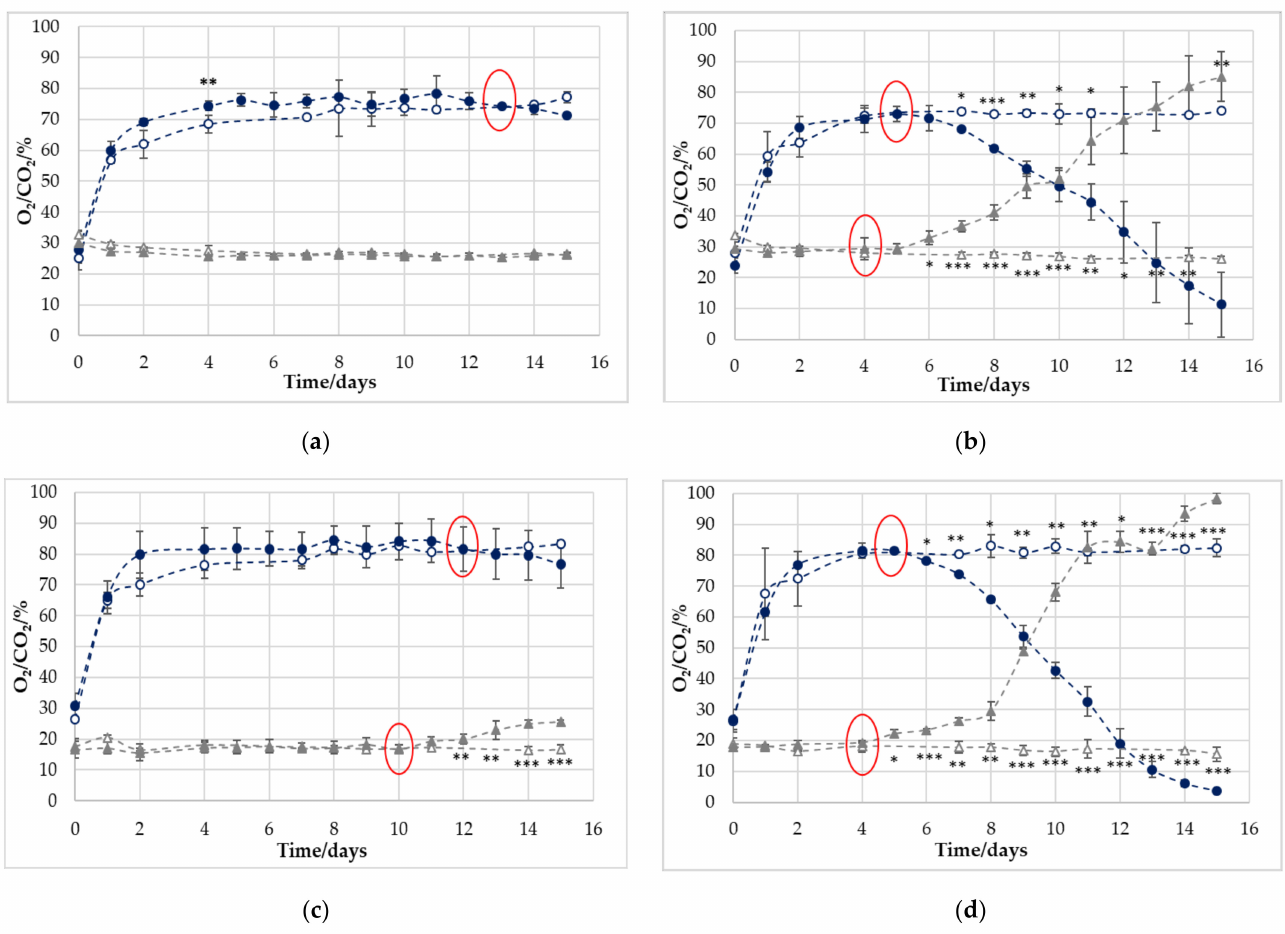
Figure 3. Development of O 2 ( / • ) and CO 2 ( (cid:52) / (cid:78) ) under different storage conditions over 15 days (cid:35) in trays with ( • / (cid:78) ) and without poultry ( / (cid:52) ): ( a ) 70% O 2 /30% CO 2 4 ◦ C ( b ) 70% O 2 /30% CO 2 (cid:35) between the curves with and without poultry: * p < 0.05, ** p < 0.01, and *** p < 0.001. The red circles mark the point when the curve of the respective gas concentration in the filled trays intersects that for the empty trays (cross-over), which indicates a microbiologically induced change in the headspace